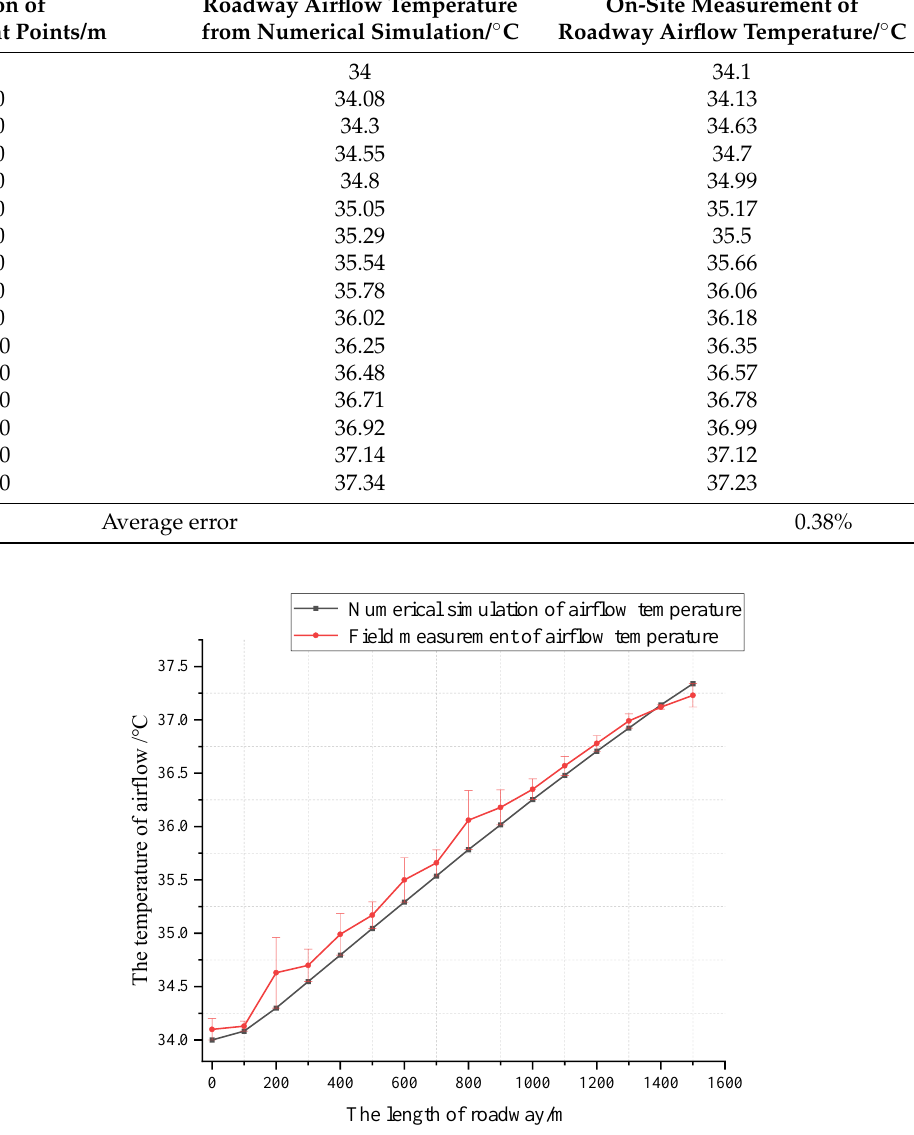
Figure 12. Numerical simulation and field measured airflow temperature in the roadway.